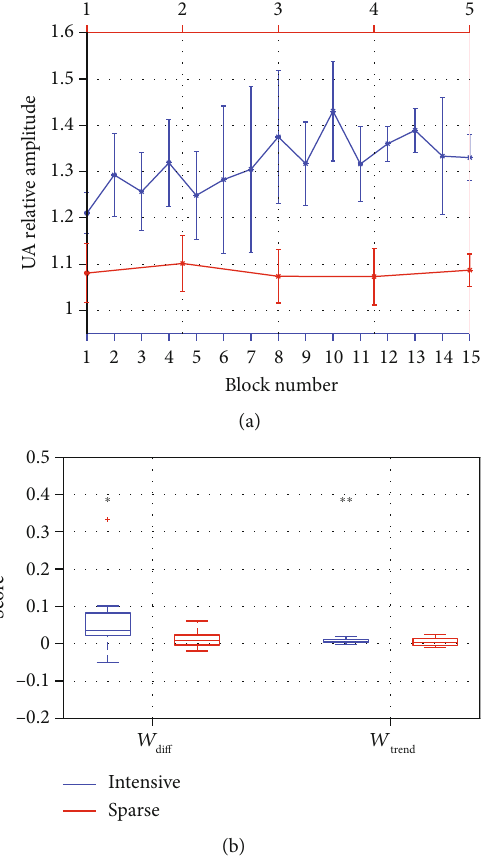
Figure 4: (a) Evolution within session for the INTENSIVE (blue) and SPARSE (red) groups during neurofeedback (NF) at Fz: mean of the upper alpha (UA) amplitude in all corresponding blocks considering the median of the participants; error bars show standard deviation. (b) Boxplot with distribution of W diff (equation (4)) and W (equation (5)) measures for the trend INTENSIVE (blue) and SPARSE (red) groups; + represents outliers; ∗ represents p values below 0.05 and ∗∗ represents p values below